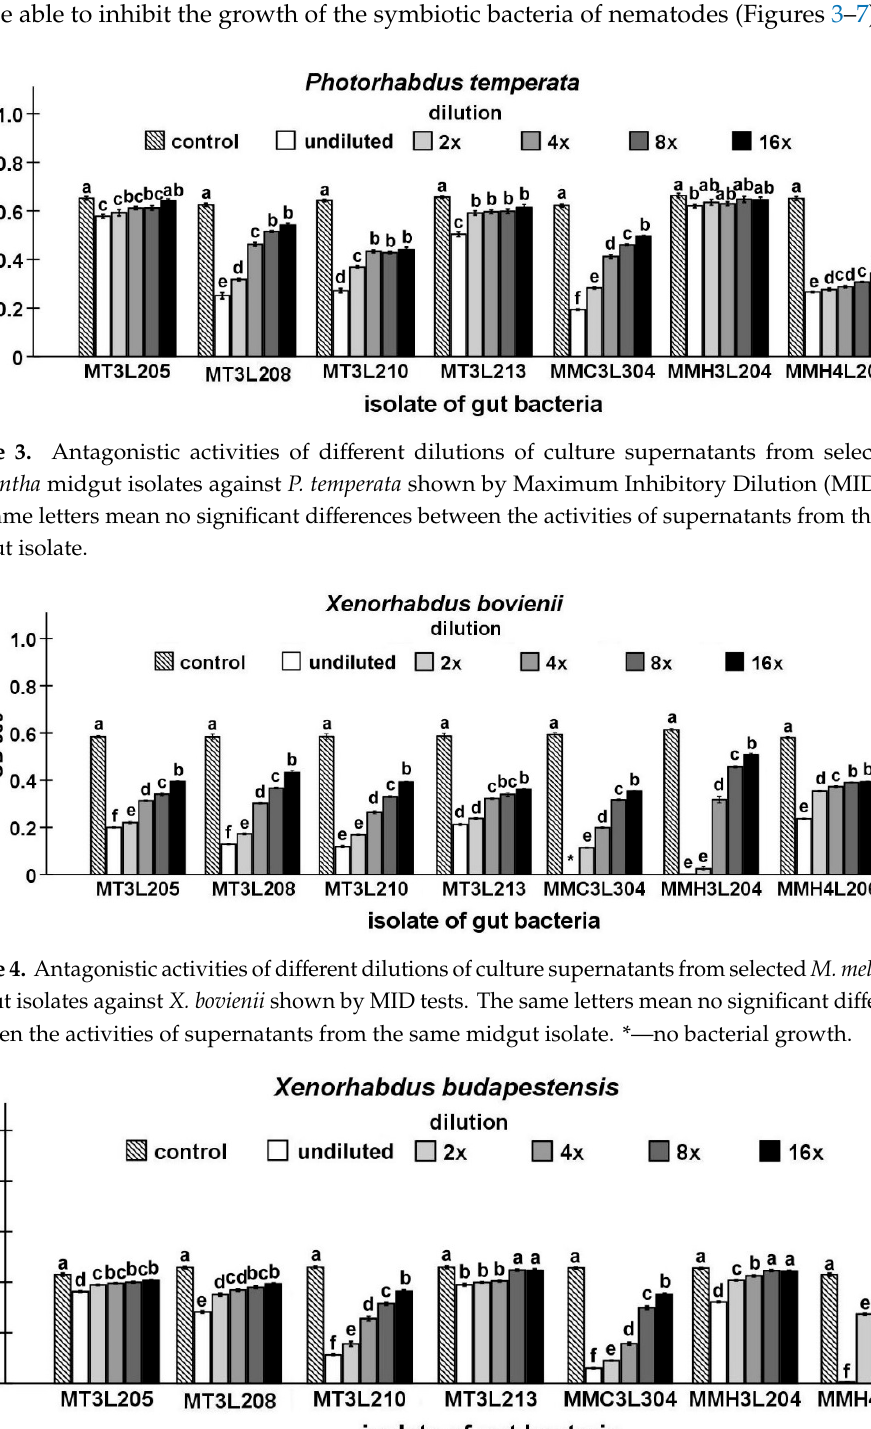
Figure 4. Antagonistic activities of different dilutions of culture supernatants from selected M. melolontha midgut isolates against X. bovienii shown by MID tests. The same letters mean no significant